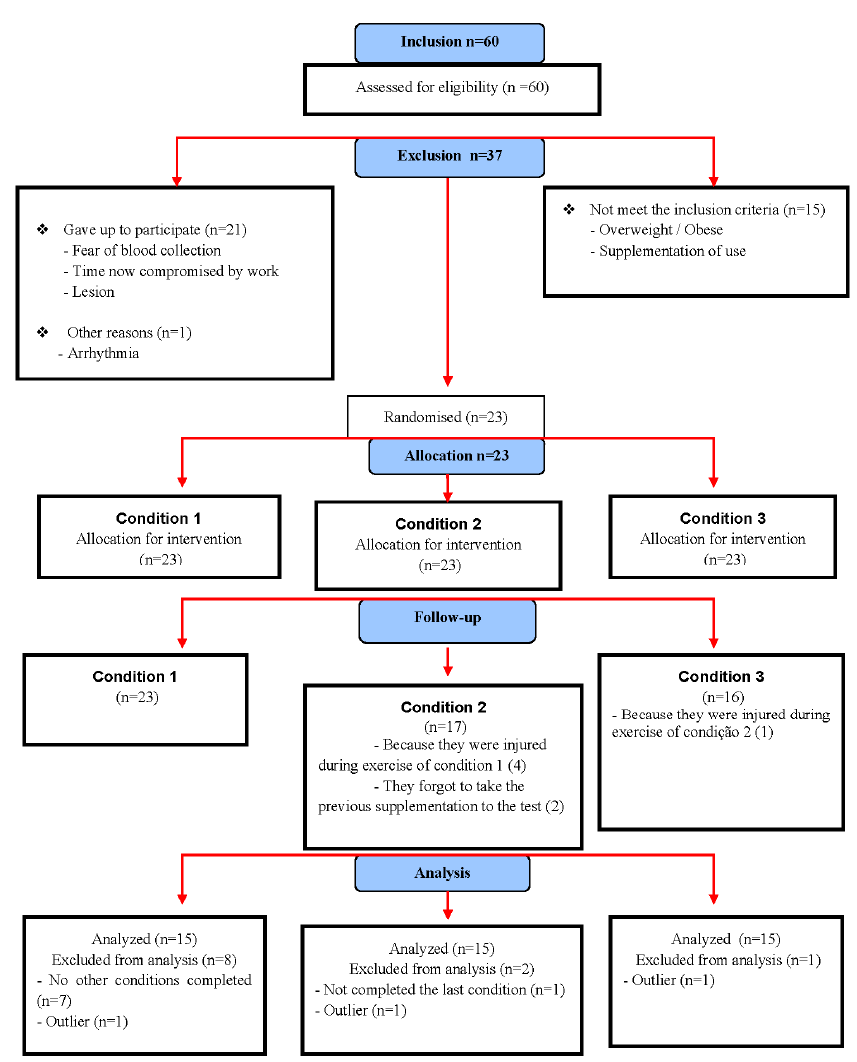
Figure 1. CONSORT flow diagram 2010.